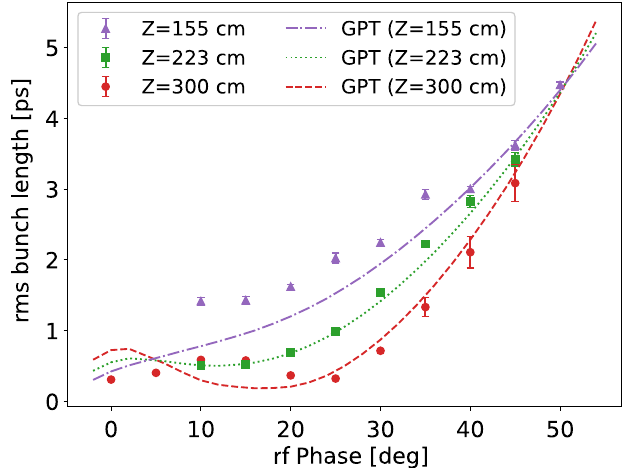
FIG. 9. Longitudinal phase space distribution obtained by (a) measurement with the TDC and a bending magnet and (b) GPT simulation at the position of Z ¼ 155 cm. The slopes of the linear chirp are (a) 27 . 4 keV = ps and (b) 35 . 0 keV =